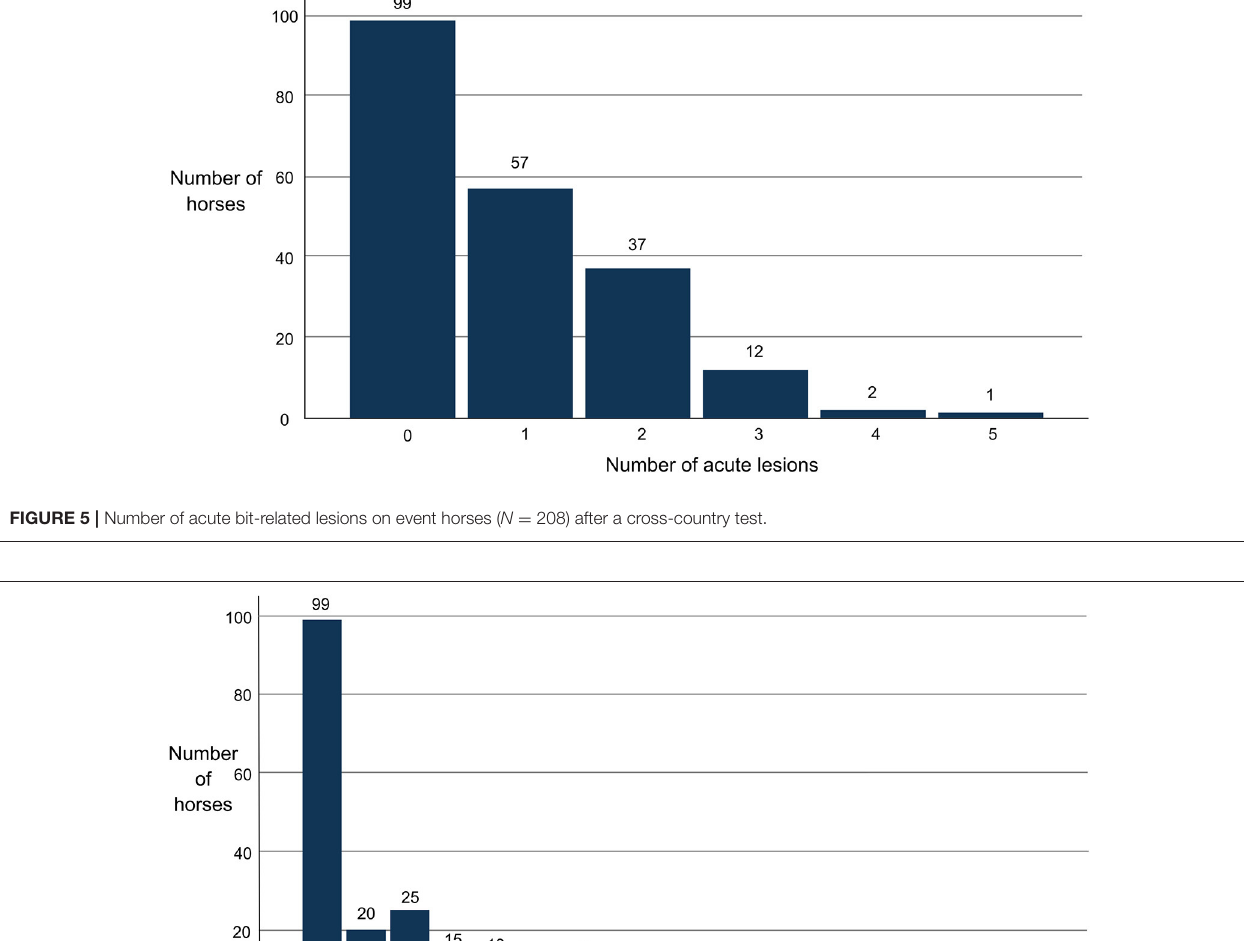
was 37% and specificity was 85%. The model correctly classified 71% of the cases. The area under the ROC curve was 73% (CI 65–80%, P < 0.001). Pearson’s goodness of fit test supported the model ( χ 2 10.4, P =